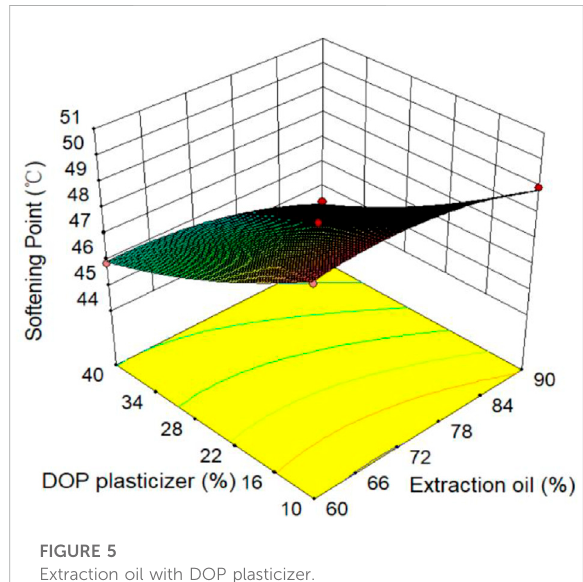
FIGURE 4 Distribution of measured and predicted softening point values.